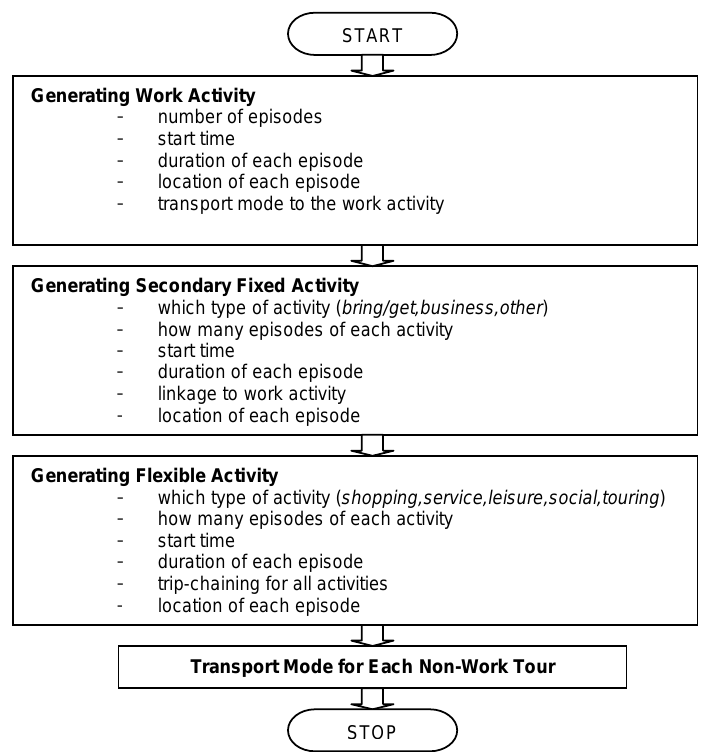
Figure 1. Schematic Representation of Main Steps of the ALBATROSS Process